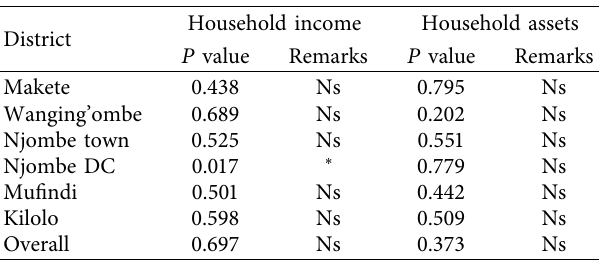
Table 6: ANOVA results on comparison between tree growers and non-tree growers.